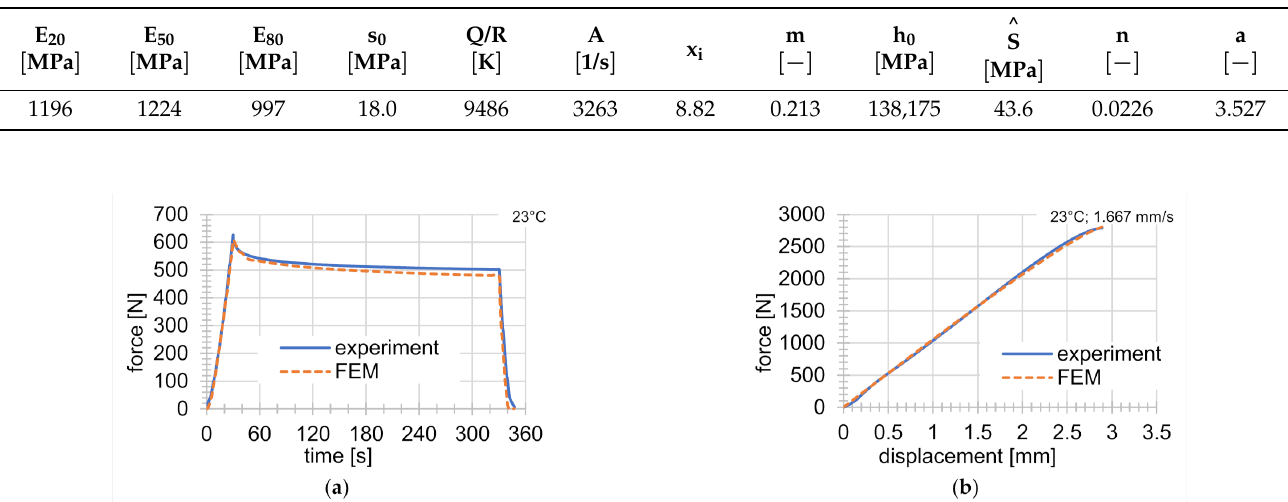
Figure 4. Comparison of experiments with FEM solutions: ( a ) indentation test at 23 ◦ C; ( b ) tensile test at 23 ◦ C and rate of deformation of 1.667 mm s − 1 .